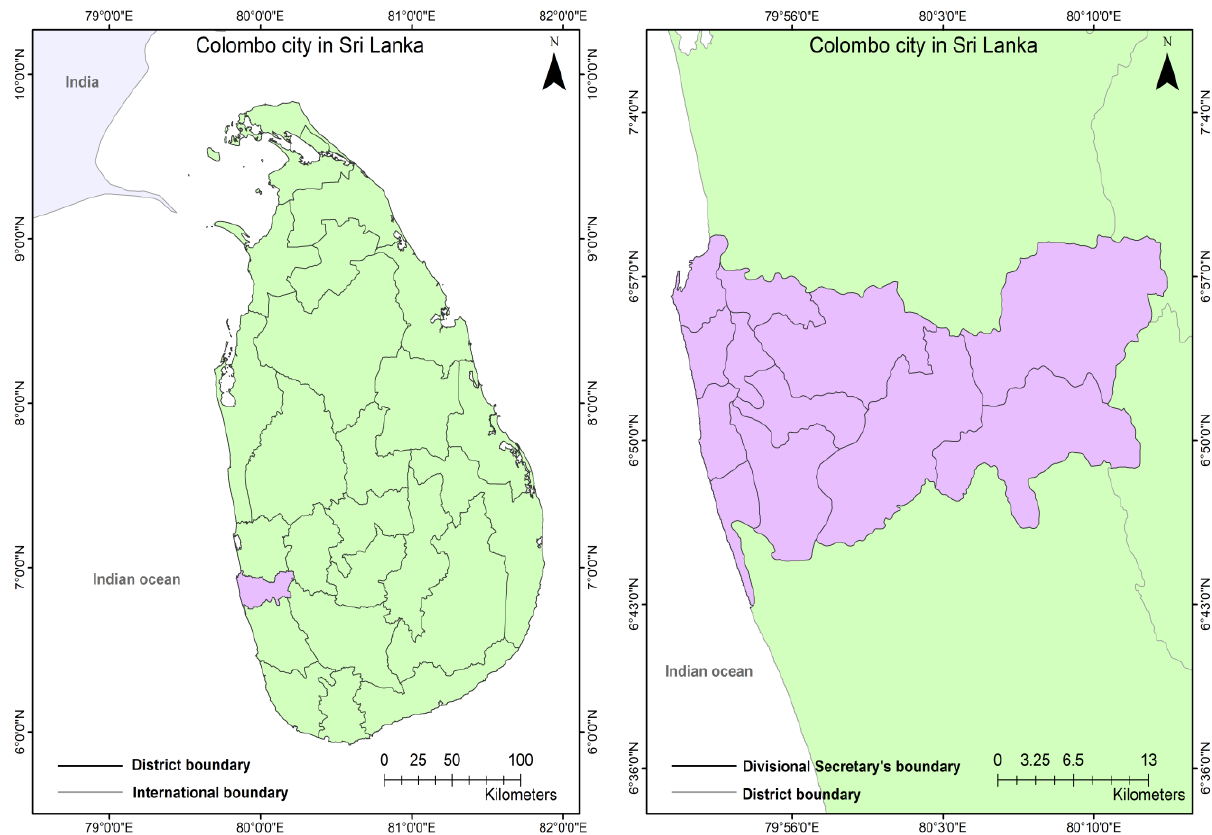
Figure 9. Map showing the location of Colombo city in Sri Lanka ( left ), and its City Corporation area ( right ).